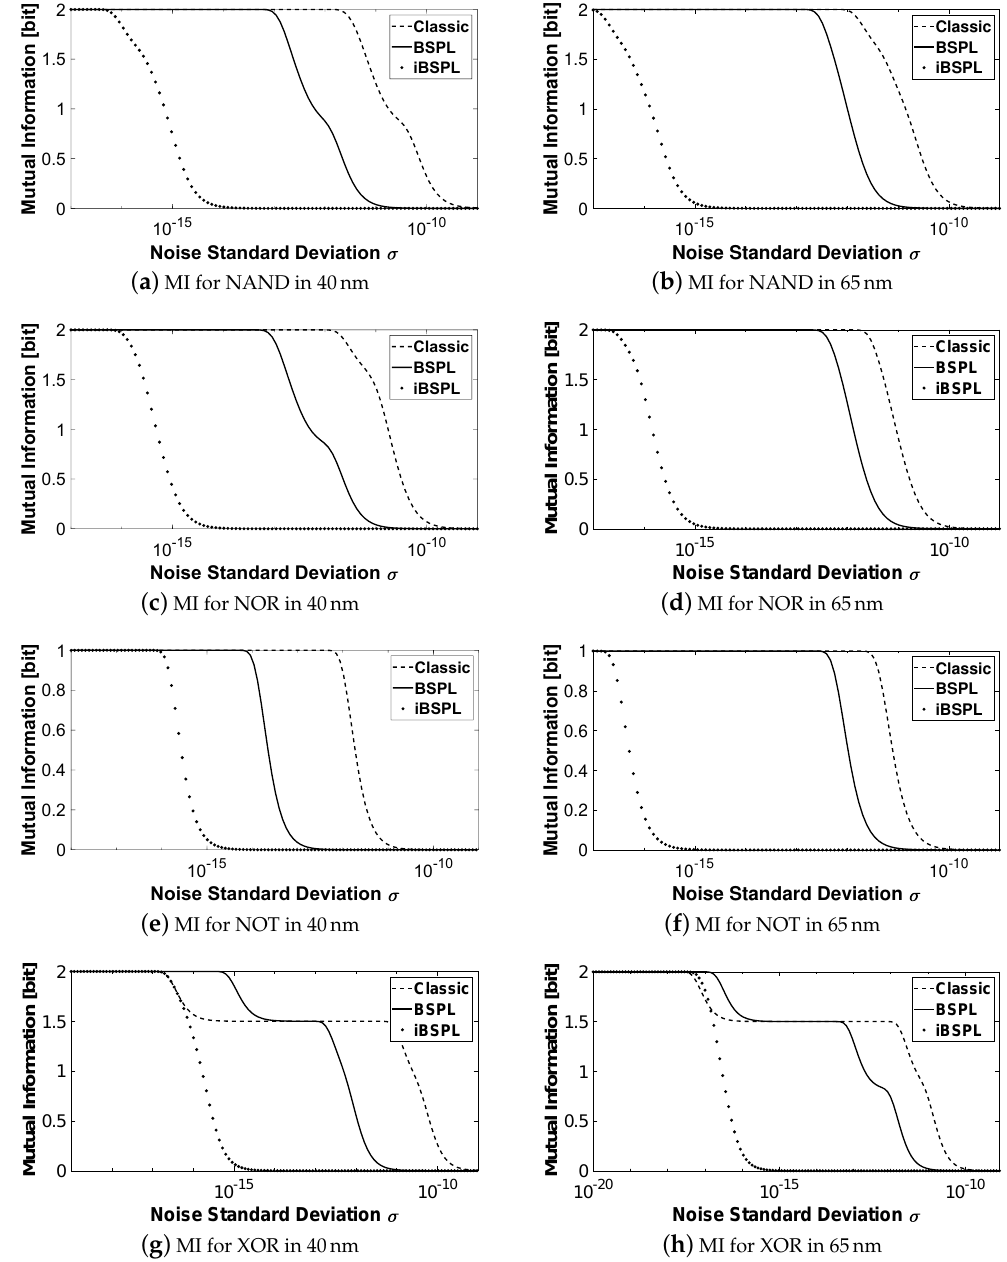
Figure 9. Information theoretic analysis of Classic, BSPL and iBSPL logic